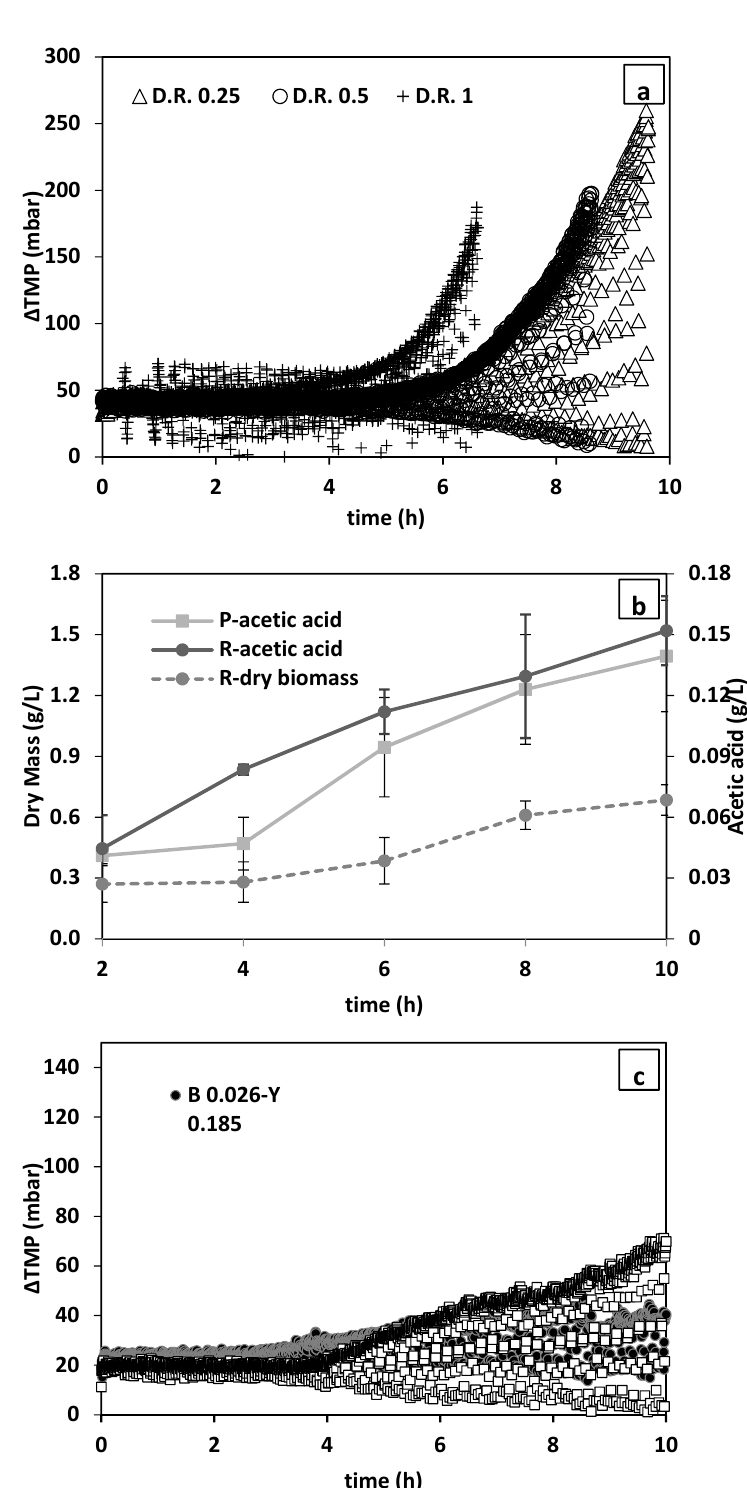
Figure 9. Changes in ( a ) TMP based on Dilution Rate (D.R.): 0.25, 0.5, and 1 1/h in double panel, ( b ) biomass concentration in the reactor and acetate concentrations inside the reactor (R) and permeate tank (P) and ( c ) TMP comparison based on initial inoculum concentration in the reactor; with bacteria 0.026 g/L and yeast 1.85 g/L, bacteria 0.023 g/L and yeast 0.047 g/L (D.R. 0.25 1/h and flux 73 L/h · m 2 ) in single panel. (The upper curves for each marker represents the change in TMP during forward filtration, and dispersed points under that curve are the latent effects of the BW pressure readings).